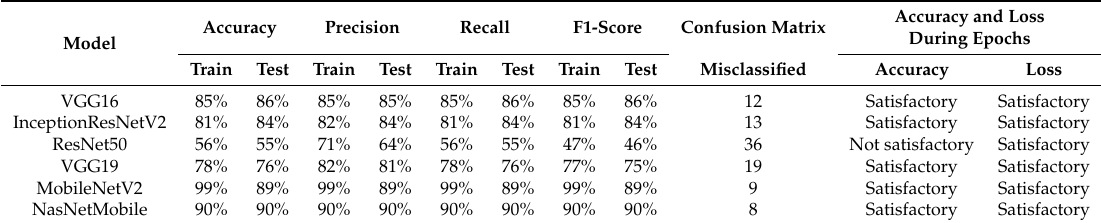
Table 7. Overall summary of the best model found considering various factor on CT scan image dataset.